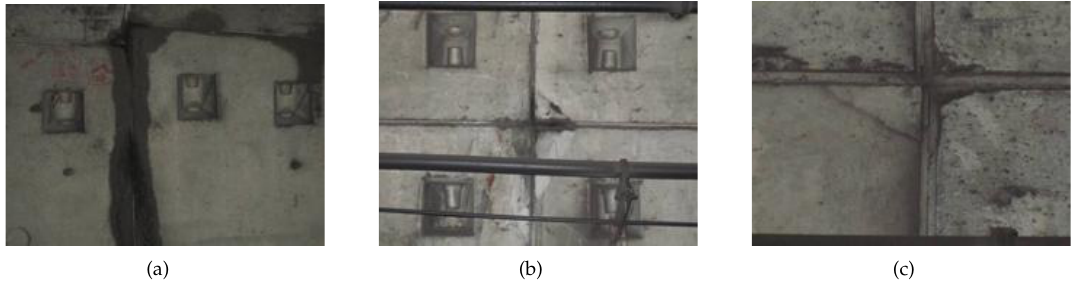
Figure 3. Surface defects in a metro tunnel: ( a ) Leakage, ( b ) Spalling and ( c )